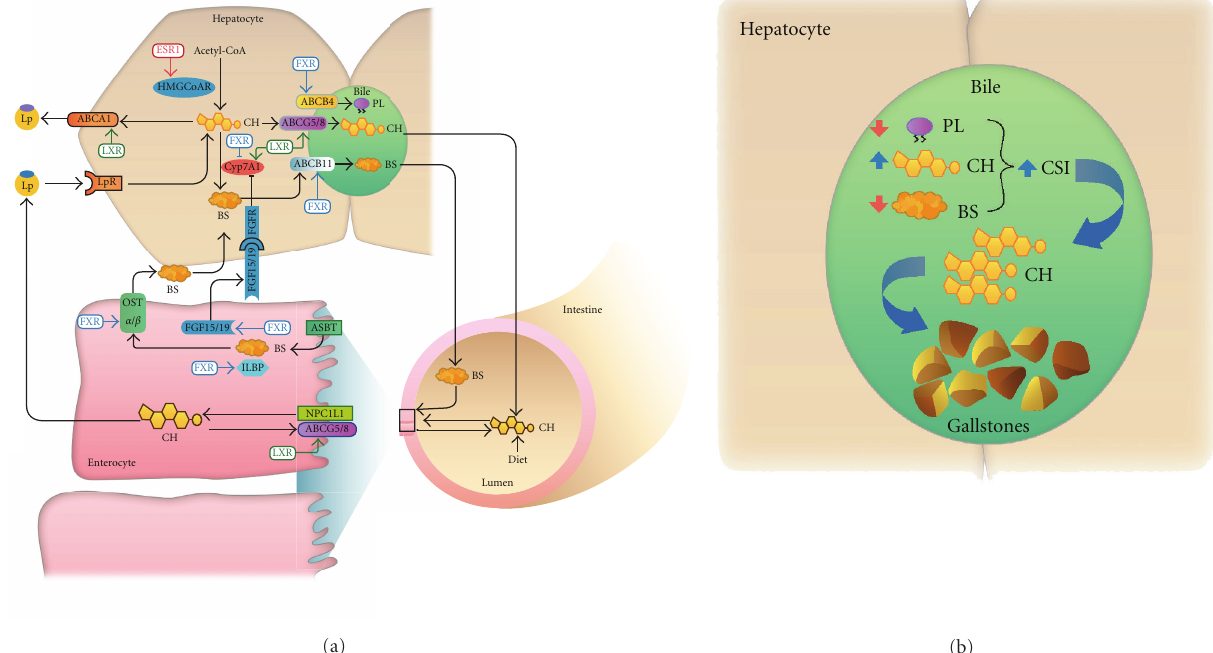
Figure 1: (a) Possible molecular mechanisms of action of nuclear receptors at the liver and the small intestine. Cholesterol derived from the diet as well as from the bile enters the intestine and is absorbed by the enterocytes through NPC1L1 and can be secreted back to the intestinal lumen by ABCG5/G8. After absorption, cholesterol is incorporated into lipoproteins (Lps), secreted into lymph and blood, and transported to the liver after triglyceride uptake in peripheral tissues. Bile salts (BSs) are absorbed in the intestine by the ASBT transporter and exit into the basolateral surface through OST α / β transporters, among others, reaching the liver via the systemic blood circulation. The hepatic pool of cholesterol originates from de novo synthesis from acetyl-CoA as well as receptor-mediated endocytosis and/or selective lipid uptake from Lp. Cholesterol can be secreted into plasma HDL through ABCA1 transporter or by formation and secretion of VLDL (not shown) or into the bile through the heterodimeric ABCG5/8 transporter. Bile is constituted by cholesterol (CH), phospholipids (PLs), and BSs. PL enters the biliary canaliculi through the ABCB4 transporter. BSs, obtained by neosynthesis from cholesterol or by uptake from plasma, are secreted into the bile by the ABCB11 transporter. The NRs control metabolism and secretion of lipids at di ff erent levels: LXR promotes cholesterol e ffl ux from the intestine and from the liver by activation of ABG5/8 and ABCA1 transporters. Also, LXR activates Cyp7A1 leading to an increase in BS synthesis in the liver. The FXR receptor regulates BS concentration at two di ff erent levels: promoting the expression of FGF15/19, ILBP, and OST α / β transporters in the intestine as well as increasing the expression of ABCB4 and ABC11 transporters and repressing Cyp7A1 expression in the liver. ESRs increase de novo cholesterol synthesis by regulation of HMGCoAR.ASBT: apical sodium bile acid transporter. OST α / β : organic solute transporter alpha/beta (b) Cholesterol gallstone formation. An increase in cholesterol and/or a decrease in BS or PL contents in the bile lead to an increase in the biliary cholesterol saturation index (CSI) triggering cholesterol precipitation into crystals and ultimately the formation of cholesterol stones within the